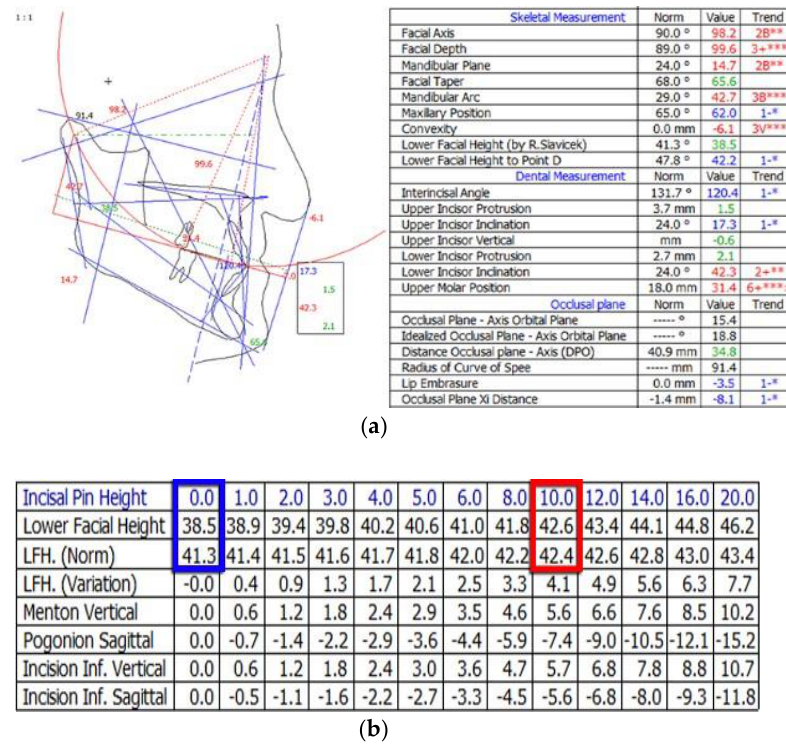
Figure 4. Initial individual cephalometric study: ( a ) digital cephalometric tracing according to Slaviceck: shows the value of the vertical dimension, the inclination of the occlusal plane and the skeletal class; ( b ) incisal pin table: blue box shows the OVD and Individual Norm values calculated from the cephalometric tracing, with the incisal pin of the articulator at 0 mm; red box shows the OVD and Individual Norm values in the Therapeutical Position (ThP), obtained with a 10 mm elevation of the incisal pin.